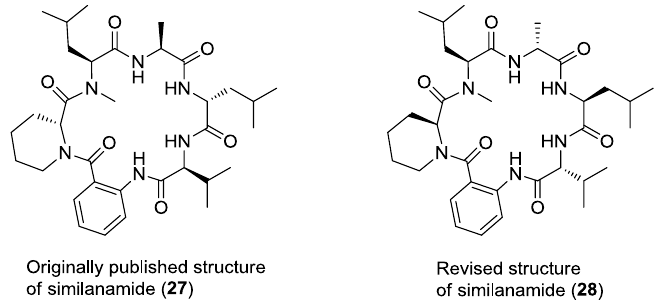
Figure 6. Structures of cyclohexapeptides 27 and 28 .